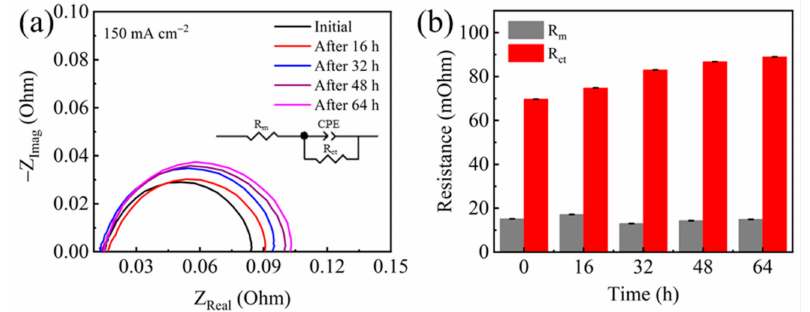
Figure 4. ( a ) Nyquist plots and ( b ) equivalent circuit fitting results at 150 mA cm − 2 before and after durability